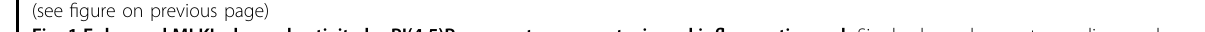
Fig. 1 Enhanced MLKL channel activity by PI(4,5)P 2 promotes necroptosis and in fl ammation. a , b Single-channel current recordings and open probability of MLKL NT in different lipid compositions ( n > 3). c The heatmap shows MLKL NT currents in various PI(4,5)P 2 concentrations. d Scatterplots of MLKL NT currents vs. dwell times. e Representative subcellular localization of GFP-PH domain. Cells were treated with or without 5 μ M Oxo-M. f The currents of MLKL channel with or without Oxo-M treatment. EC indicate the extracellular solution. g Statistical analysis of MLKL currents ( n ≥ 3). h Necroptosis was detected through Annexin V-FITC (AV)/PI staining. L929 cells were treated with 20 ng/mL T and 20 μ M Z after PIP5K transfection or ISA treatment (left). Statistical analysis of AV/PI staining (right). i Schematic representation of the residues examined by the solution MLKL NT structure. j Current traces of MLKL mutants 22A, 34A, and 22A/34A in the presence of different concentrations of PI(4,5)P 2 . k Cell viability of MLKL – / – HeLa cells after co-transfection with PIP5K or PIP3K and MLKL mutant constructs. l The volcano plots for the comparison between proteome patterns of BV2 cells treated with PBS or LPS. m Representative function enrichment analysis of upregulated DEGs. Functional terms were labeled and color-coded with log 10 transformed P -value (Fisher ’ s exact test). n PPI network of proteins shown in Supplementary Fig. S8. Proteins participating in inositol phosphate metabolism are labeled with blue. o Cell viability of BV2 cells after LPS treatment. p , q Potassium ef fl ux levels in LPS-treated BV2 cells and LPS/Q/C-treated BMDM cells (left). Statistical analysis results were shown (right). r Detection of K + ef fl ux level of LPS-treated BV2 cells with or without ISA (left). Statistical analysis results were shown (right). s Enhanced MLKL channel activity by PI(4,5)P 2 promoted necroptosis and in fl ammation via disturbing ion homeostasis and accelerating potassium ef fl